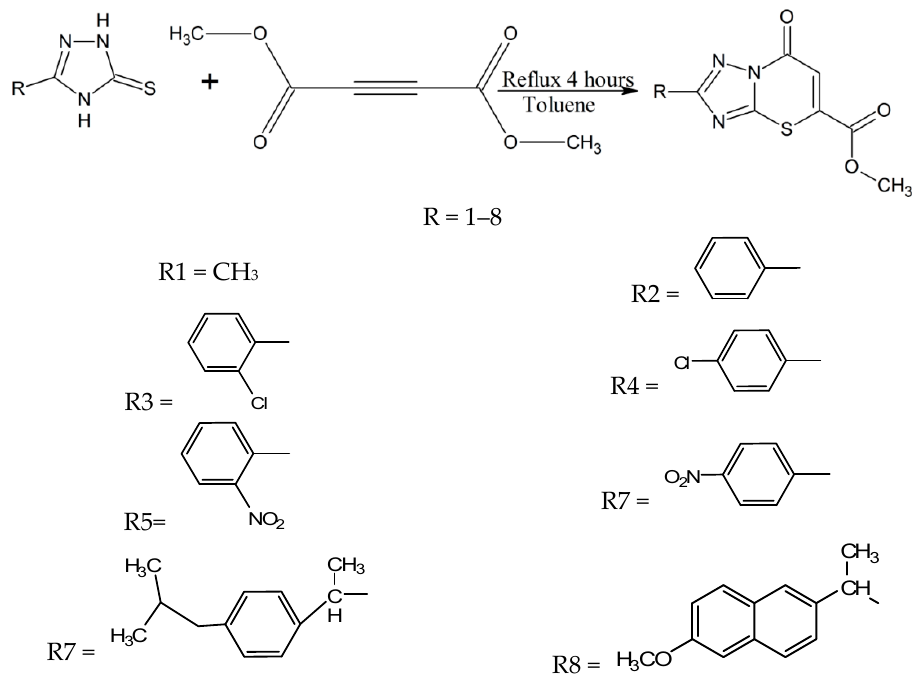
Scheme 9. Synthesis of thiazine derivatives using 1,2,4-triazole-5-thiones as a starting material